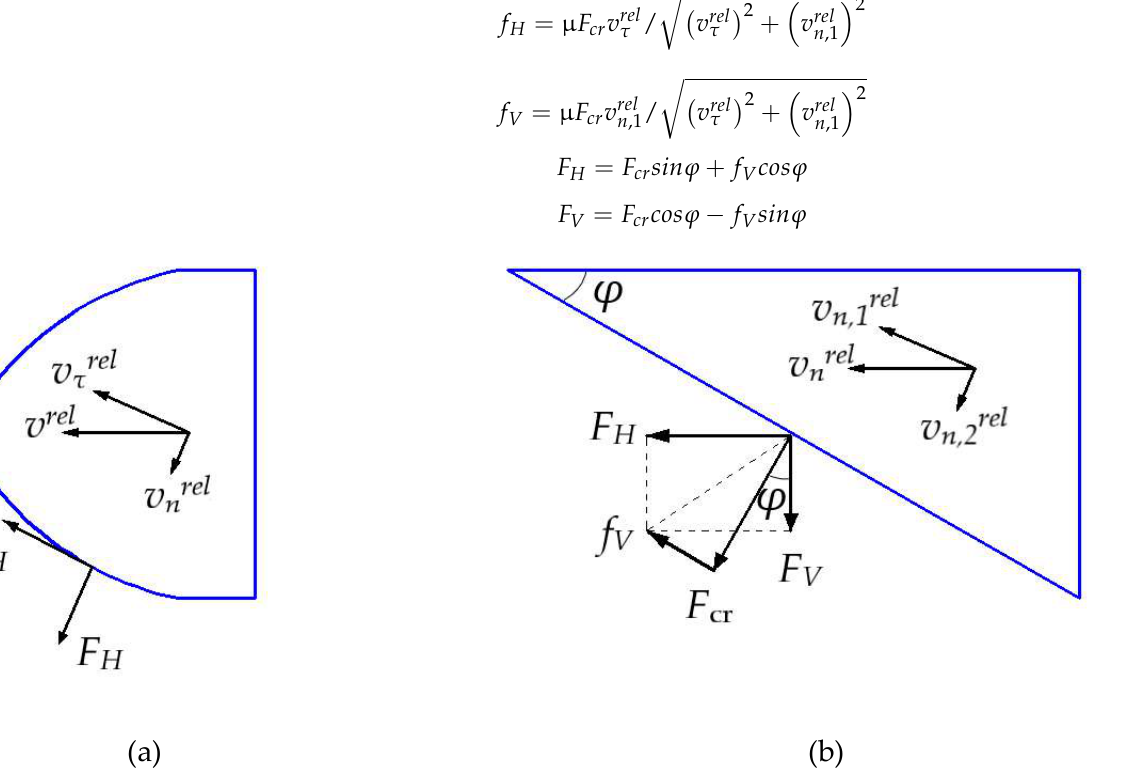
Figure 3. Definition of ice force and velocity components. ( a ) horizontal plane; ( b ) vertical plane.